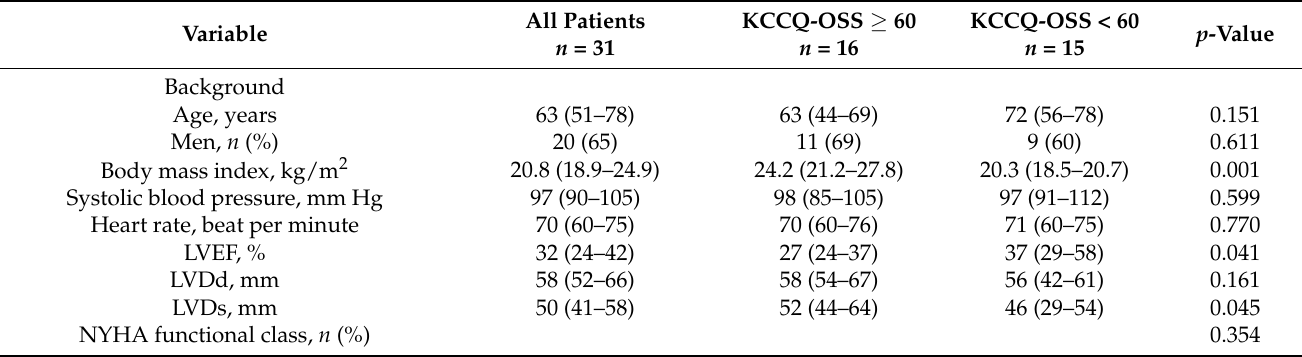
Table 1. Baseline